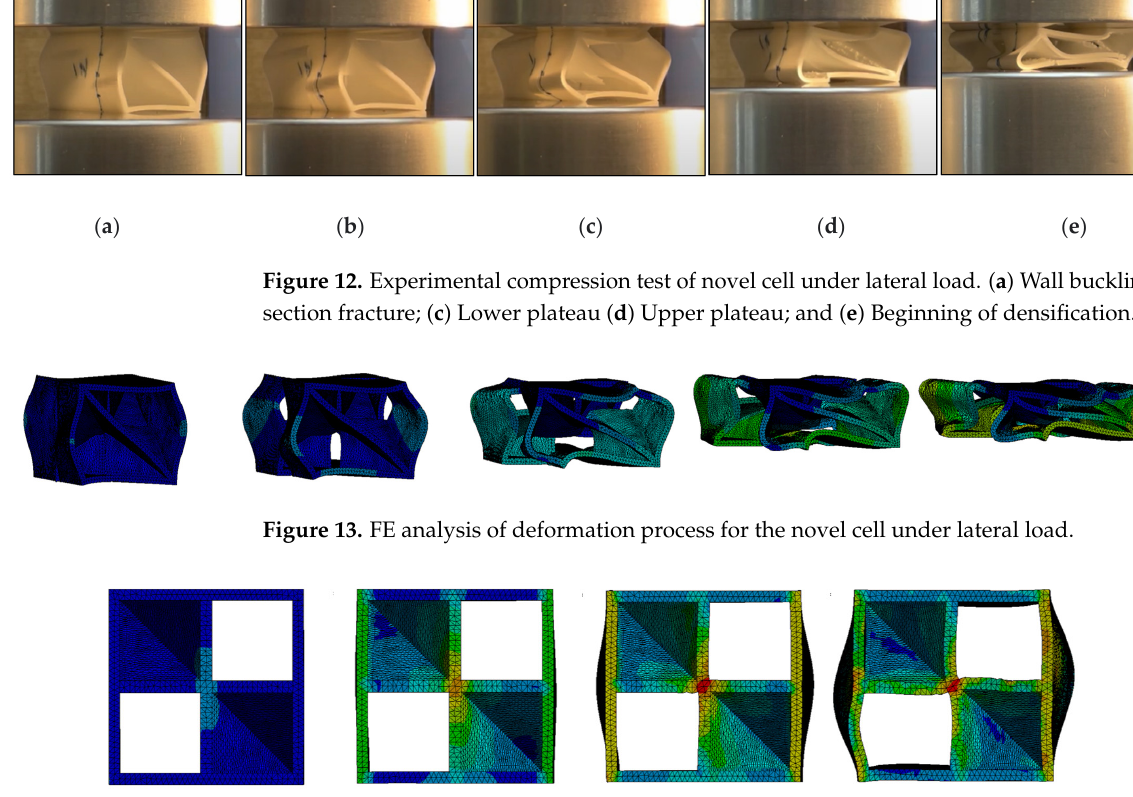
Figure 15. Load vs. displacement curves for novel cell under lateral load: comparison between ex- perimental and FEA. Figure 16. Experimental load vs. displacement curves for hexagonal cell under axial load. Figure 17. Experimental compression test of standard hexagonal cell under axial load.